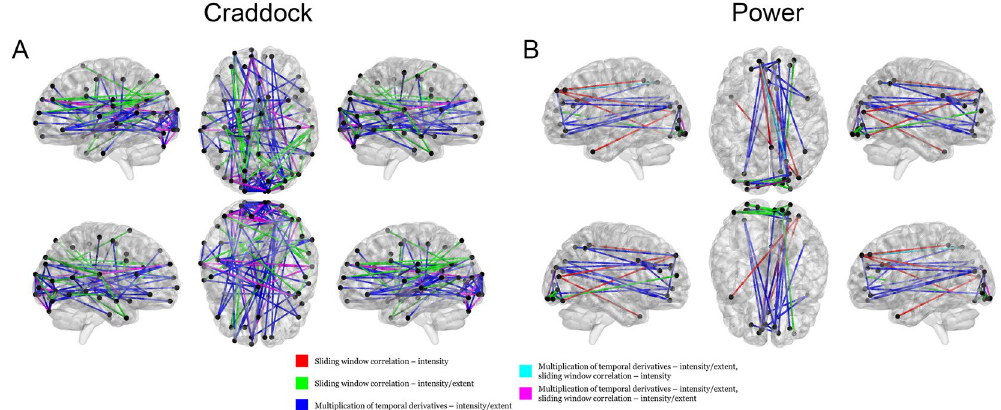
Figure 1. Dynamic rsFC networks in which NBS revealed a significant influence of esketamine. NBS 31 was performed with each of the 8 methodological combinations to probe for networks in which esketamine had a significant influence on dynamic rsFC in comparison to placebo. Significant networks were only shown for the contrast esketamine < placebo, i.e. esketamine only demonstrated significantly negative effects on dynamic rsFC. Except for three combinations, one significant network per rsFC estimation method, per atlas, per statistical measure (intensity/extent) was revealed. See Table 1 for additional information on the networks elucidated. Red, green, dark blue, light blue and green lines denote with which statistical methods (intensity and/or extent based on NBS 31 ) on which rsFC data (exponentially weighted sliding-window correlation method based on Zalesky et al . 25 and/or MTD based on Shine et al . 26 ) edges (connections) are significant. A and B denote parcellation based on Craddock et al . 29 and Power et al . 30